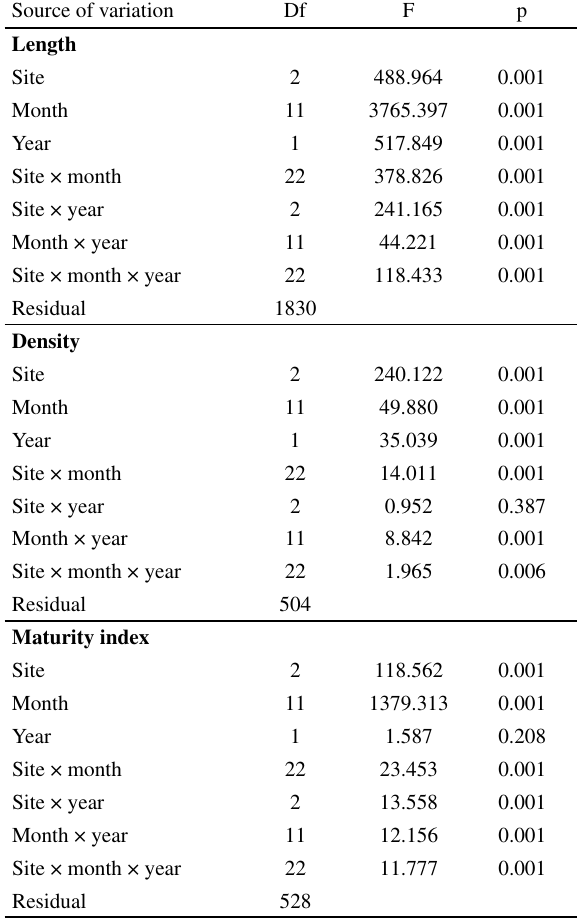
Table 1. – Three-way ANOVA testing the effect of site (3 levels), month (12 levels) and year (2 levels) as fixed factors on the thalli length, density and maturity index of Sargassum muticum communities on the Moroccan Atlantic coasts. Df, degree of freedom; the global F ‐ ratios and p ‐ values are shown.